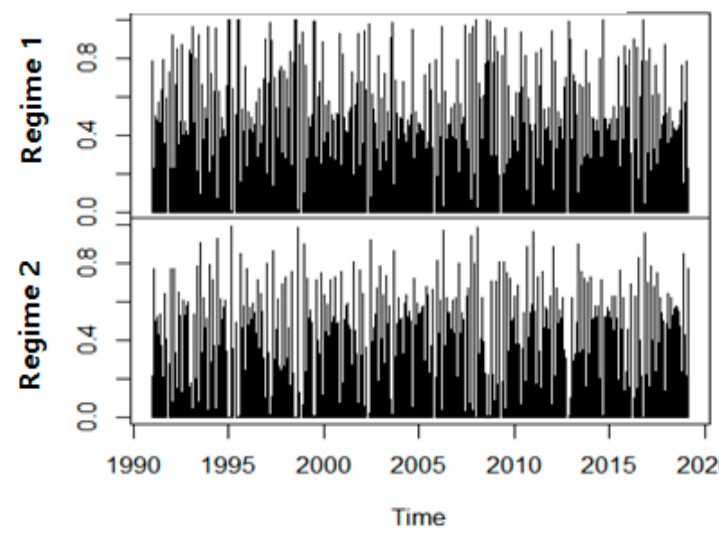
Figure 2. The filtered probabilities of belonging to regime 1 with high-volatility and regime 2 with